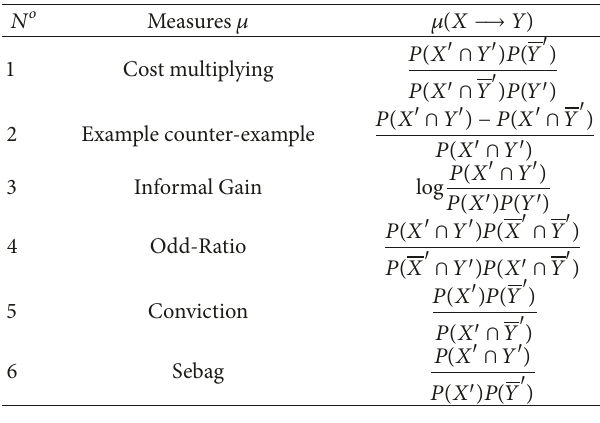
Table 1: The probabilistic quality